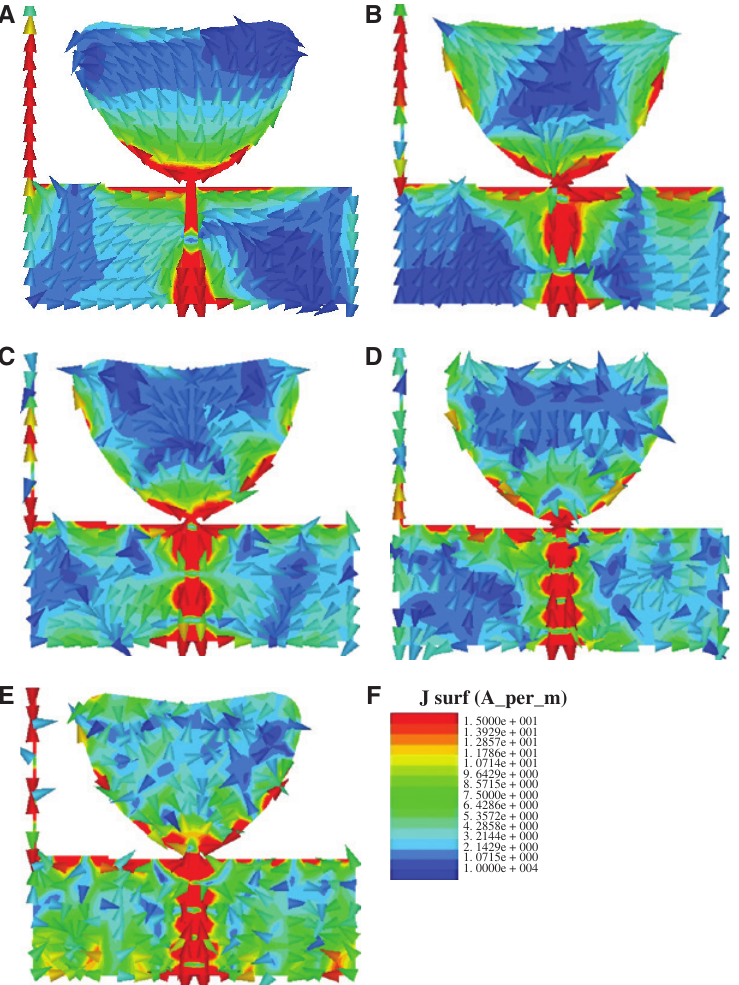
Figure 2: Surface current distribution of the proposed antenna at (A) 4 GHz, (B) 8 GHz, (C) 12 GHz, (D) 18 GHz, and (E) 20 GHz (F)